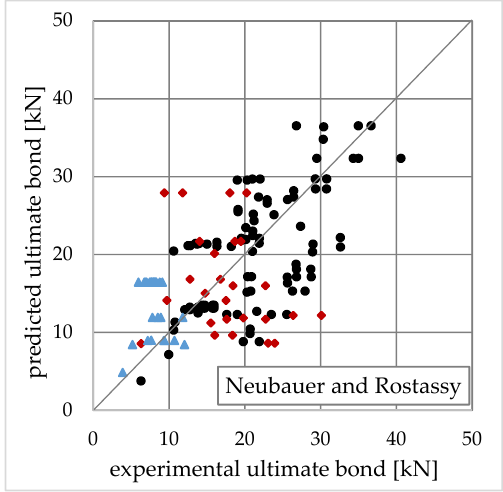
Figure 7. Test vs. predicted bond force using the Neubauer and Rostasy model [19].